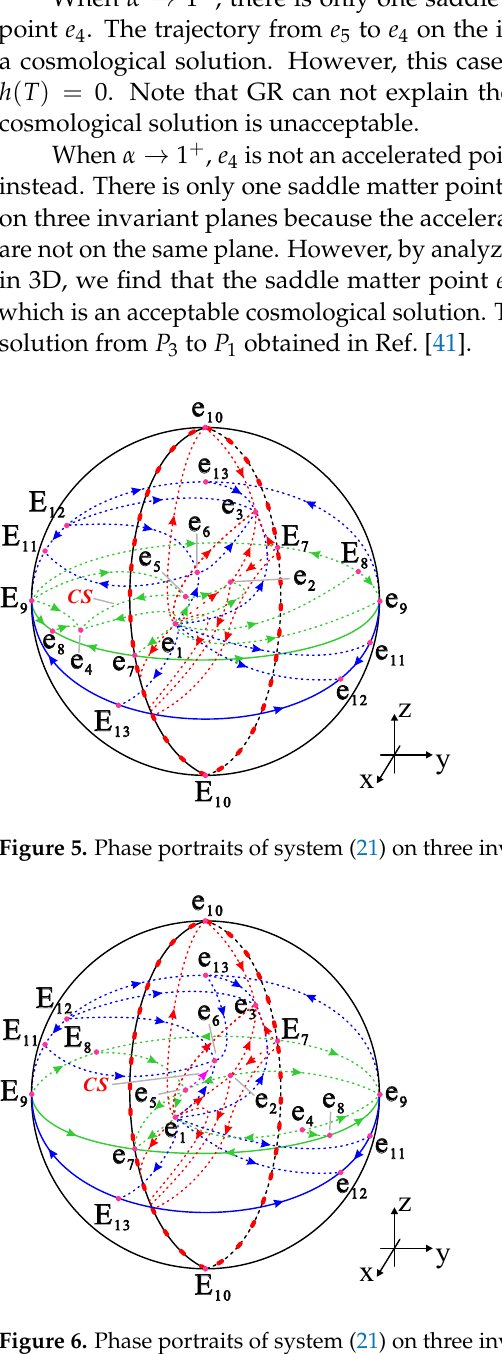
Figure 6. Phase portraits of system (21) on three invariant planes when α → 1 +